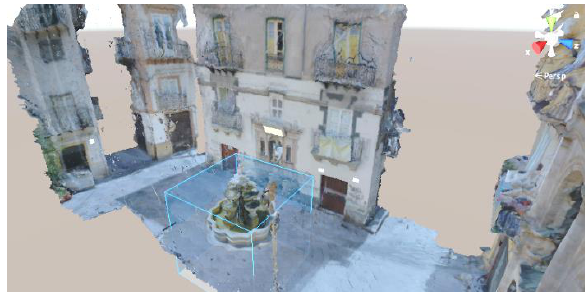
Figure 11. The construction of virtual environment for the AR application.